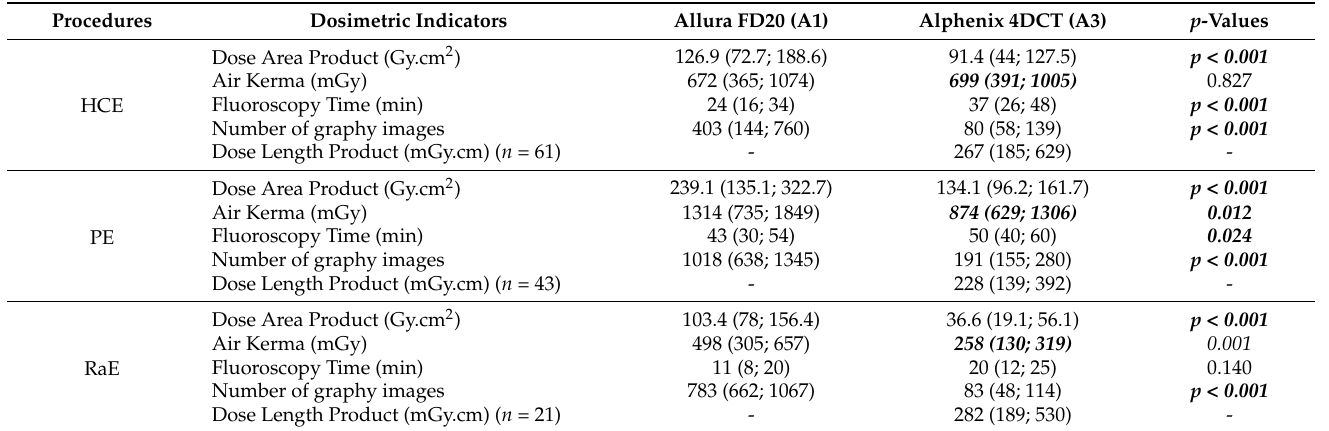
Table 3. Comparison of the dosimetric indicators between the Allura FD20 (A1) and 4DCT Alphenix (A3) C-arms systems for 3 embolization procedures.